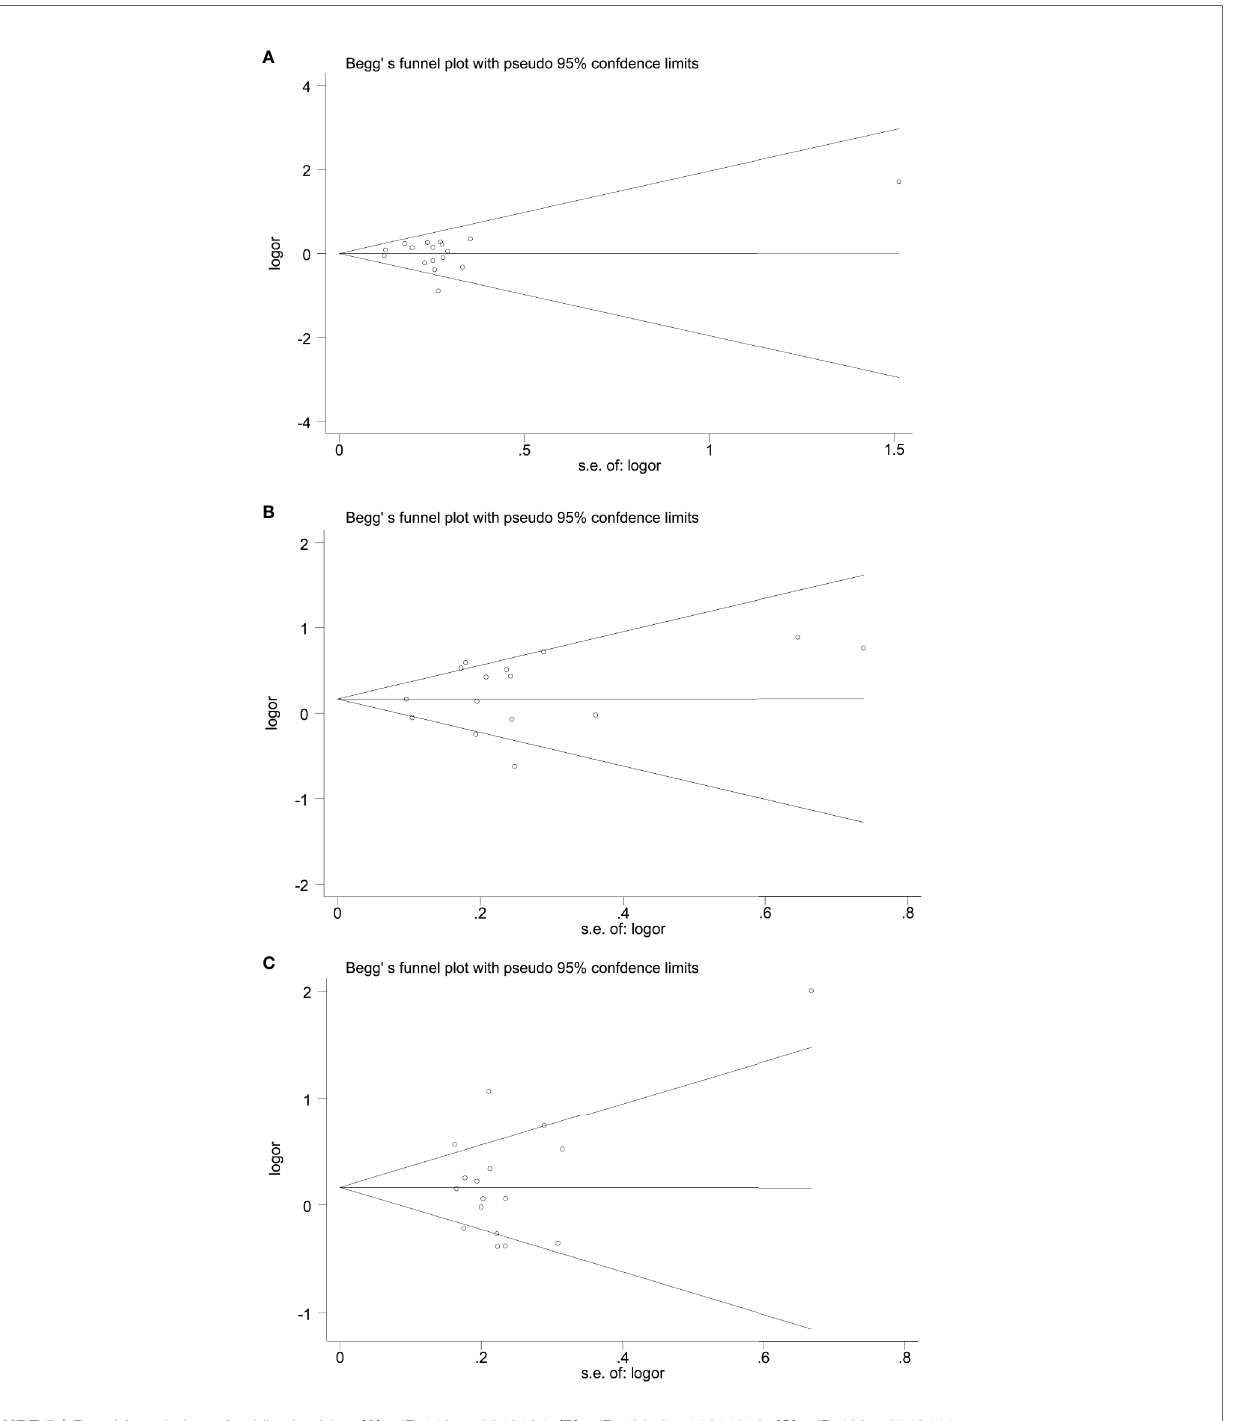
FIGURE 5 | Begg ’ funnel plots of publication bias. (A) miR-146a rs2910164; (B) miR-196a2 rs11614913; (C) miR-499